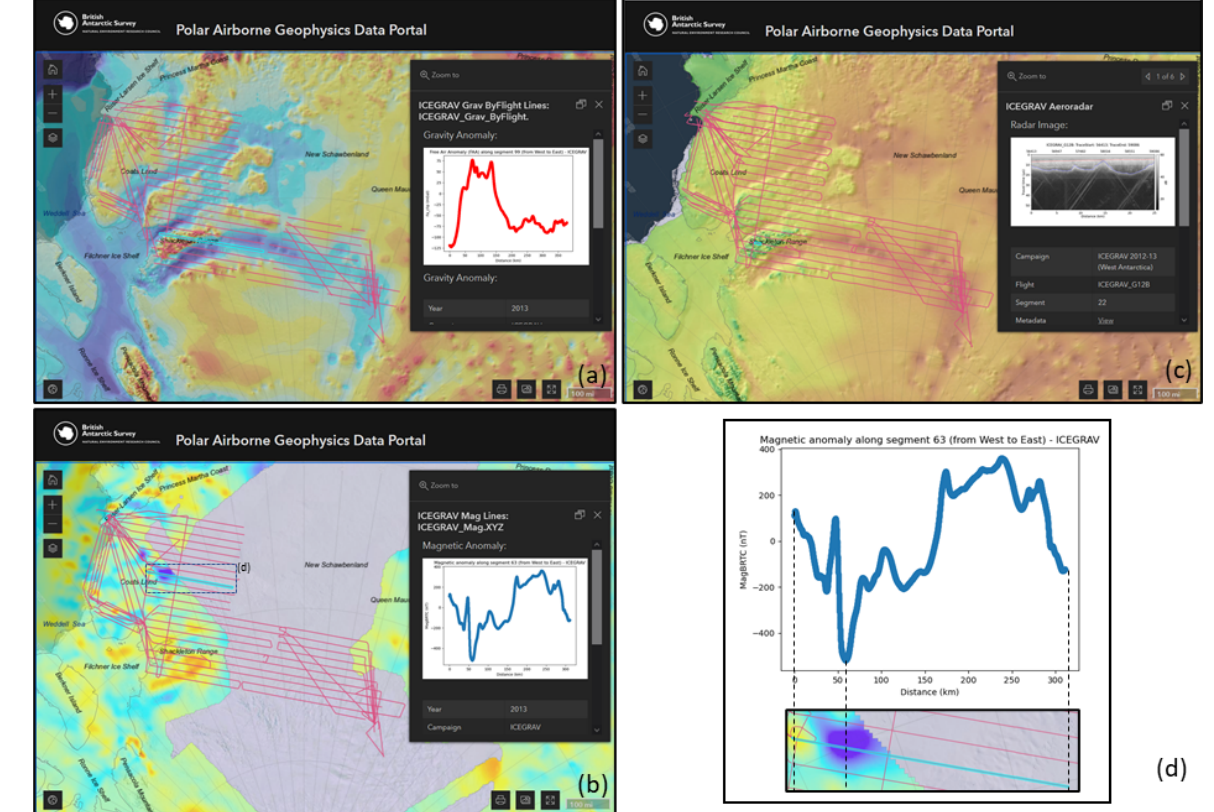
Figure 10. Screenshots of the Polar Airborne Geophysics Data Portal showing the three aerogeophysical products for the 2012–2013 ICE- GRAV survey with different basemaps. (a) ICEGRAV aerogravity survey with the BEDMAP2 bed-elevation basemap. (b) ICEGRAV aero- magnetic survey with the magnetic-anomaly basemap from Goodge and Finn (2010). (c) ICEGRAV aeroradar survey with the ice-thickness basemap from BEDMAP2. (d) Magnetic anomaly along the profile highlighted in (c) with a comparison with the aeromagnetic anomaly map from Goodge and Finn